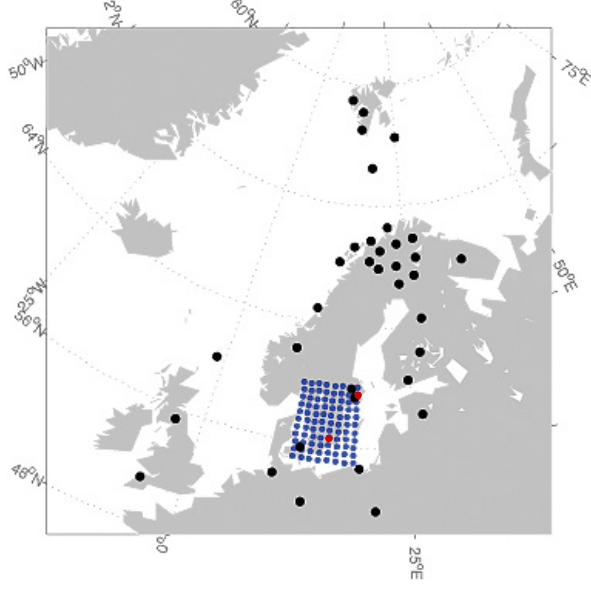
Fig. 1. Magnetometer stations (black) and a dense grid for the in- terpolation (blue). The observatory in the SW corner of the grid is Brorfelde, and the two observatories in the NE corner of the grid are Lov¨o and Uppsala. The two grid points, coloured in red, correspond to the locations for which the geoelectric and geomagnetic fields are plotted in Figs. 4, 5, 7 and 8. The more northern is for the July 1982 event, and the more southern is for the October 2003 event.